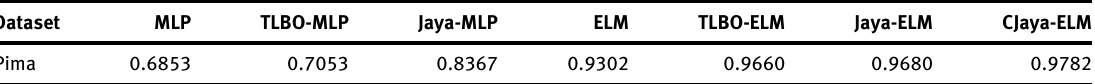
Table  : AUC values of MLP, TLBO-MLP, Jaya-MLP, ELM, TLBO-ELM, Jaya-ELM and CJaya-ELM models.